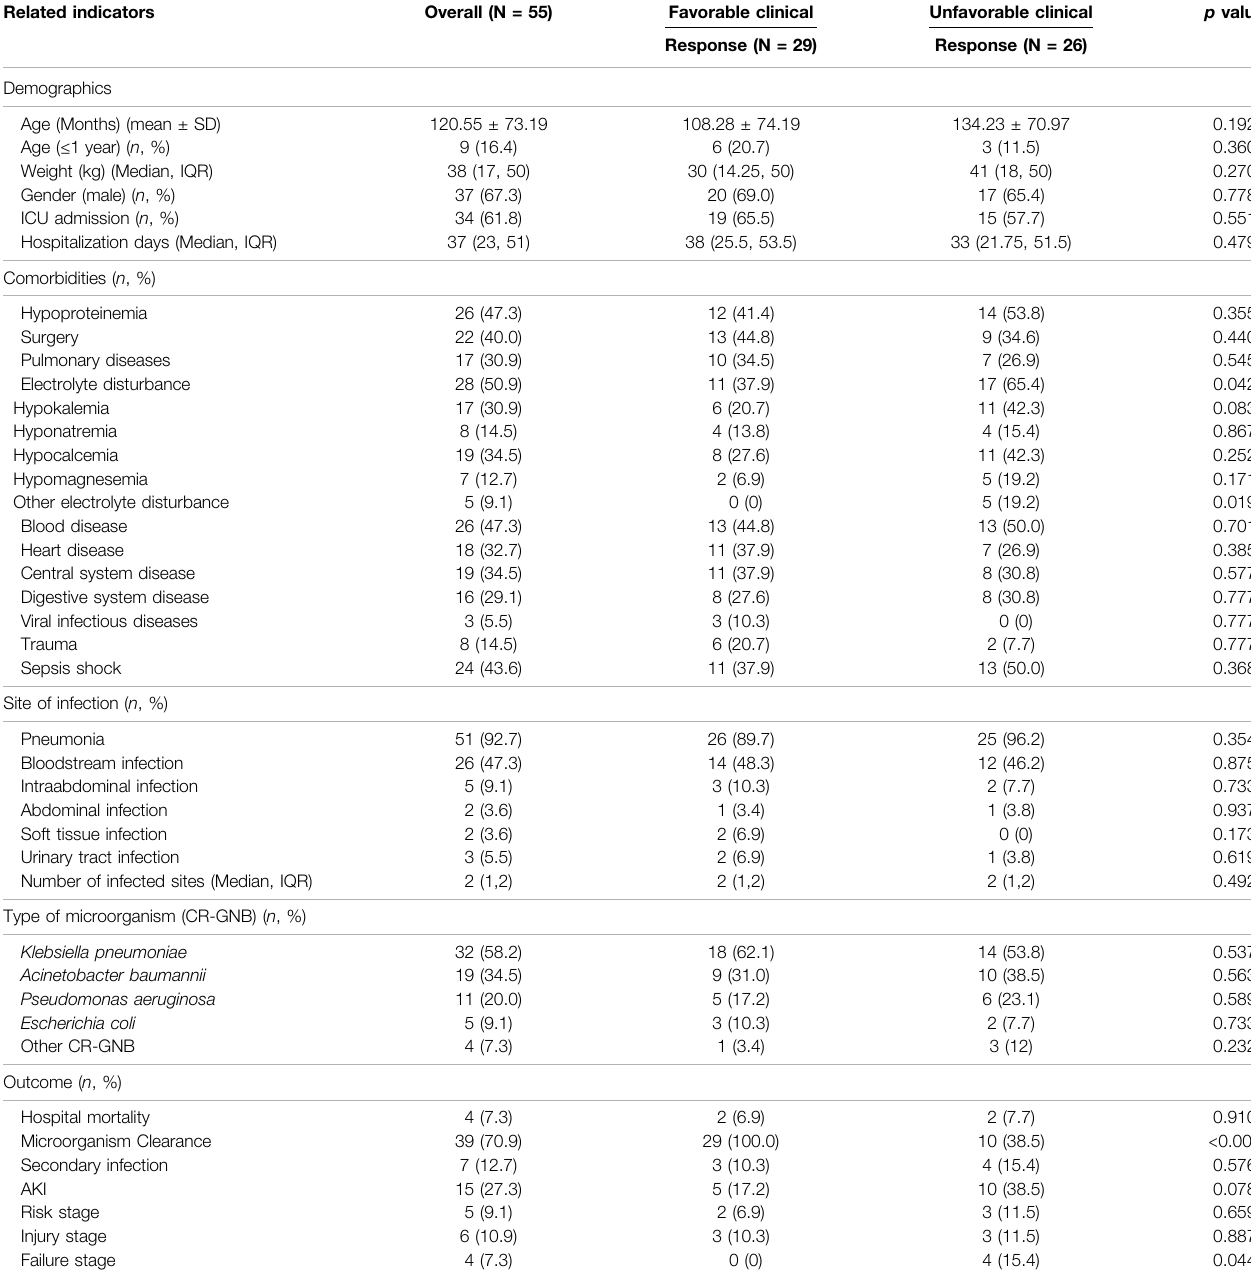
TABLE 1 | Patient characteristics with favorable and unfavorable clinical responses during polymyxin B